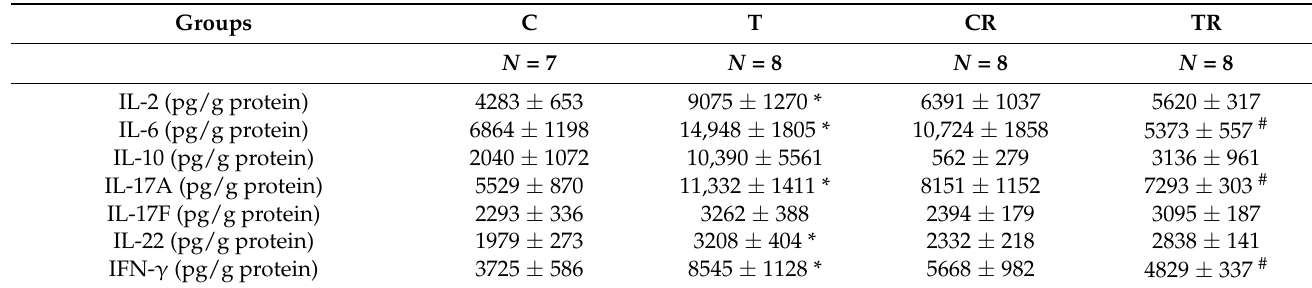
Table 3. Kidney tissue cytokine levels.